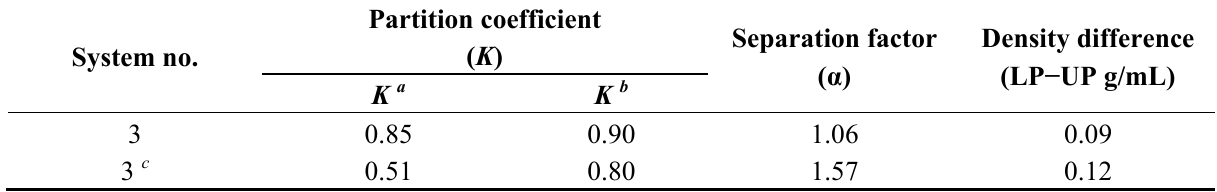
Table 2. The partition coefficient ( K ) and separation factor ( α ) values of NOS-6 and 472C. System